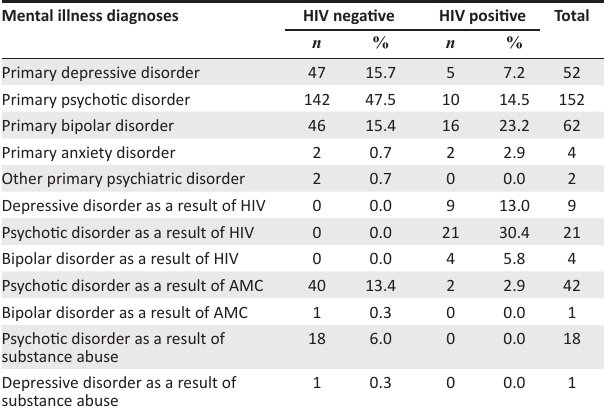
TABLE 1: Characteristics of the participants. TABLE 2: Types of psychiatric disorders associated with HIV co-morbidity.